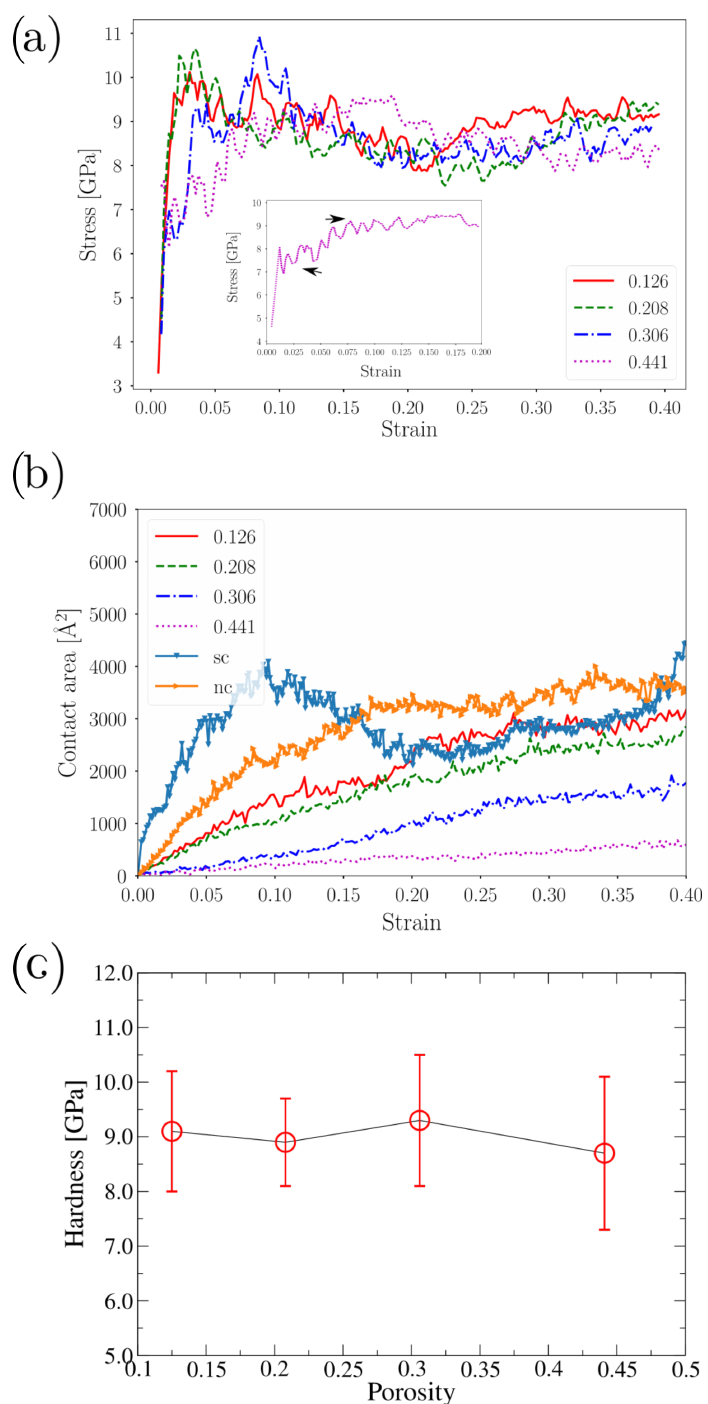
Figure 2. ( a ) Contact pressure curve. (inset) Magnification of contact pressure for φ = 0.441 case, where arrows indicate a “plateau” on the contact pressure curve. ( b ) Atomic contact area as a strain function. ( c ) Hardness as a function of the NS